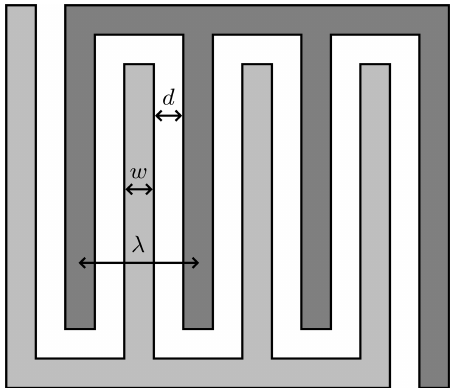
Figure 2. Schematic of an interdigital electrode structure. Both electrodes consist of four digits of width w separated by a dis- tance d